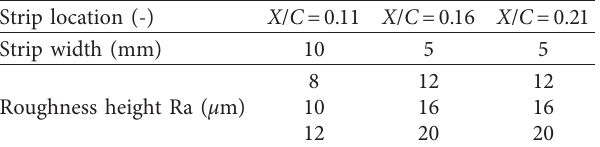
Table 2: Roughness strip location and its average height (Ra) on the compressor